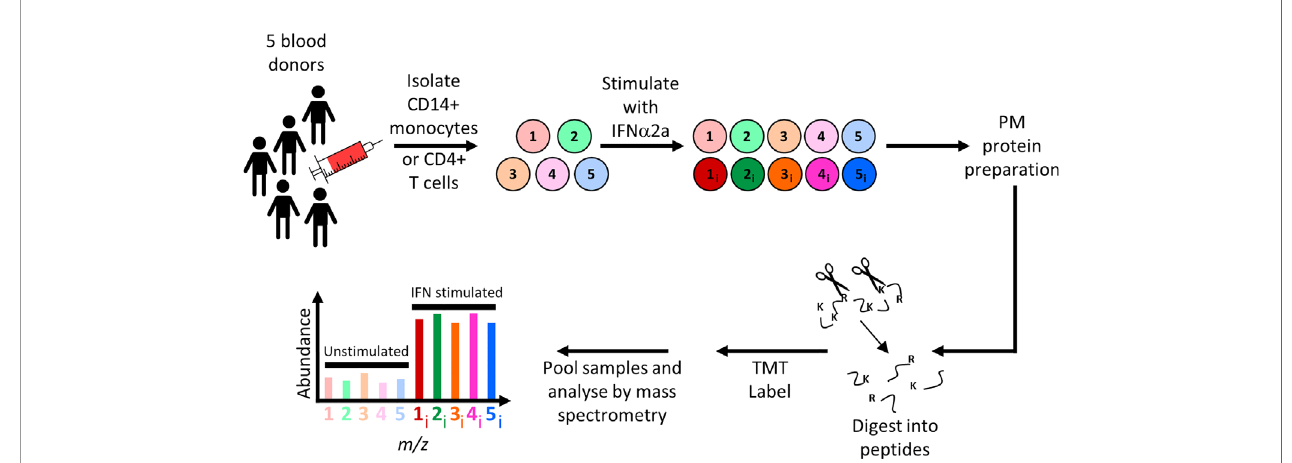
FIGURE 1 | Schematic of experimental work fl ow for plasma membrane proteomic analysis of IFN a 2a-stimulated and unstimulated primary CD14+ monocytes or CD4+ T cells. For each cell type, fi ve independent donations were cultured overnight in the presence or absence of IFN a 2a, before selective oxidation and aminooxy-biotinylation of cell surface glycoproteins. Proteins were enriched on streptavidin beads, digested with trypsin, and peptides from each of the 10 samples labeled with tandem mass tag (TMT) reagents then subjected to MS3 mass spectrometry.